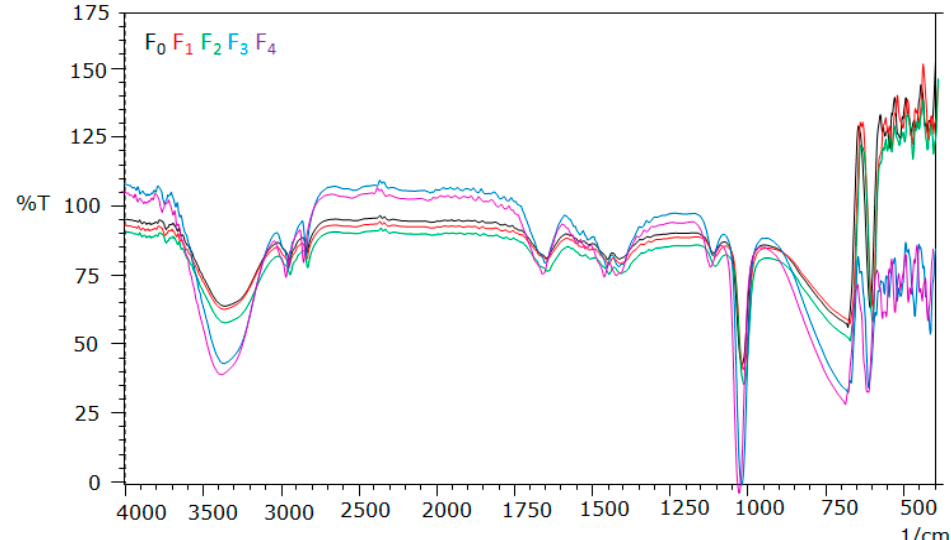
Figure 8. Analysis of FT-IR of Polyvinyl alcohol/Corn starch/Patchouli oil/Hydrogel films loaded with silver nanoparticles (F 0 ; F 1 ; F 2 ; F 3 ; and F 4 ).